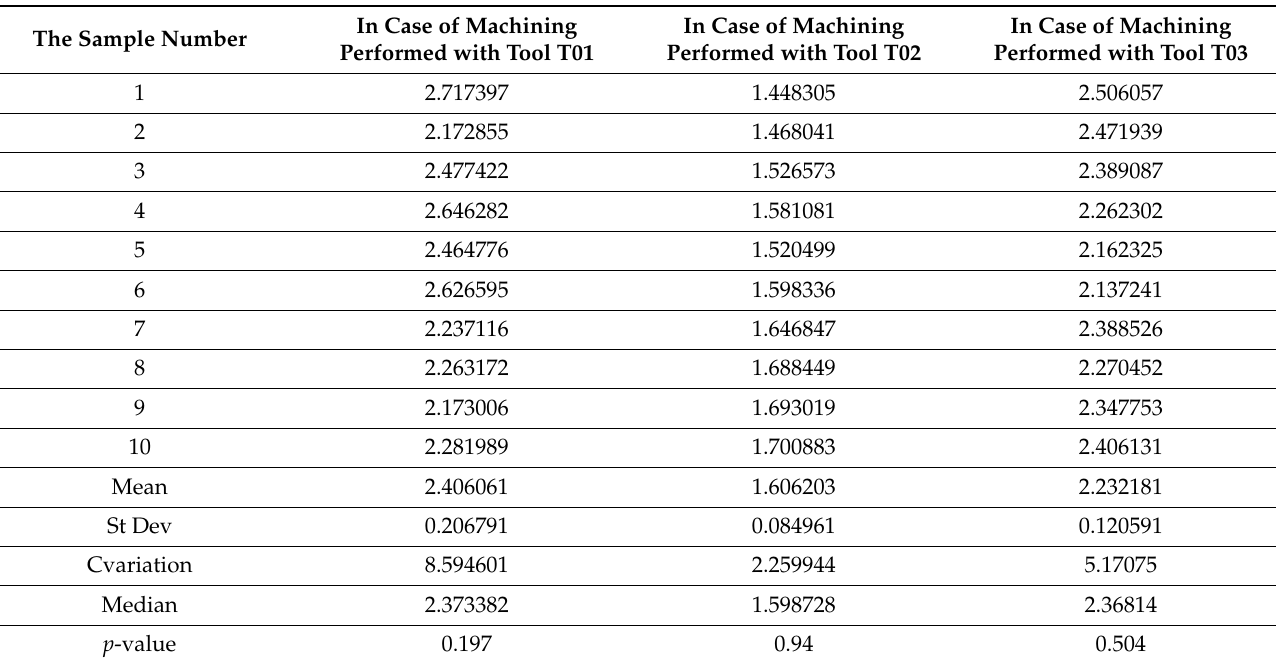
Table 3. The measured roughness values for the 10 samples, Ra, µ